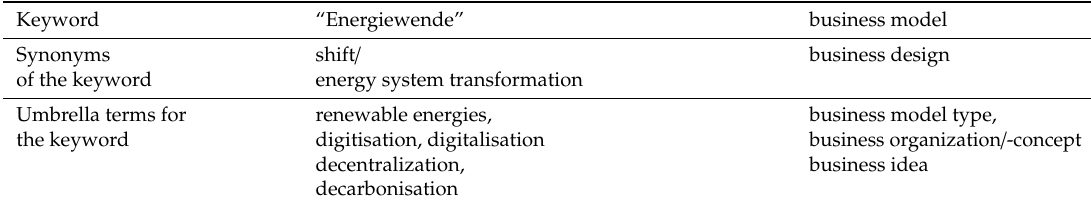
Table A1. Keywords of the Secondary Data Collection (Literature